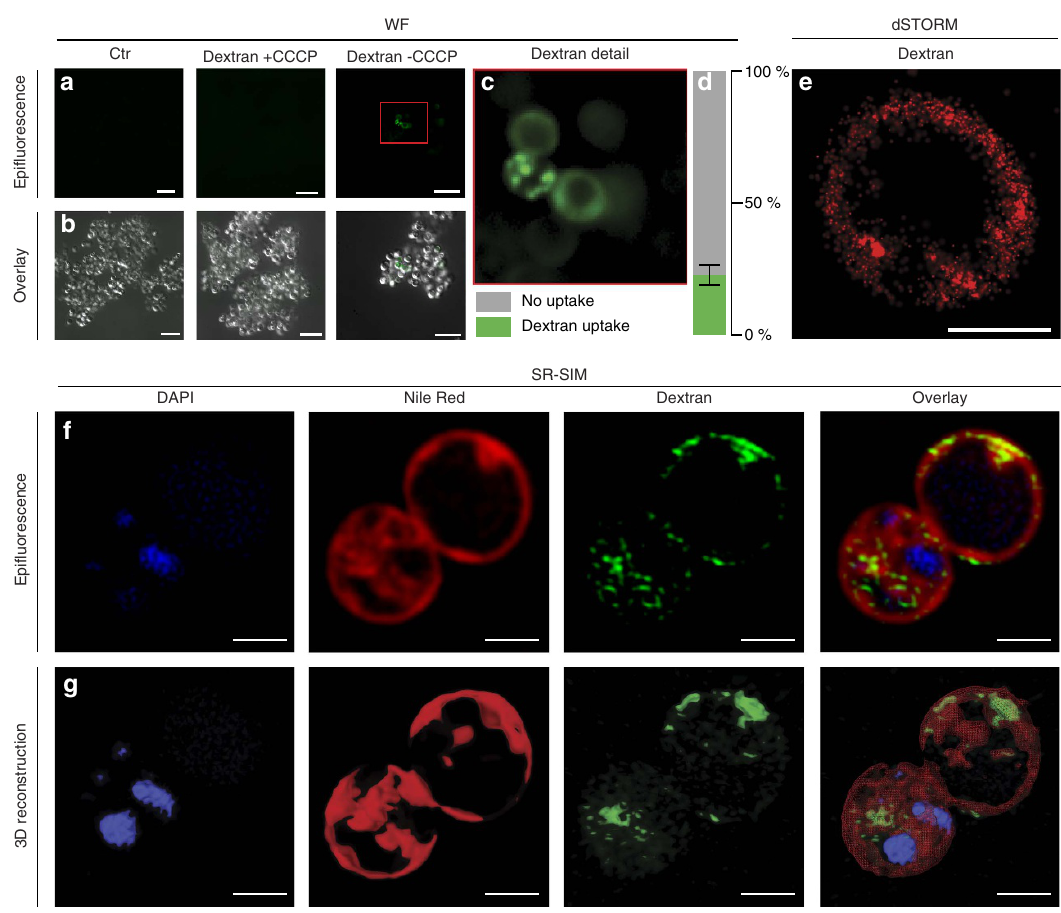
Figure 5 | Gemmata obscuriglobus takes up high-molecular weight dextran polysaccharides. ( a – c ) Wide field (WF) microscopy of G. obscuriglobus cells that were either untreated (Ctr) or fed with fluorescein-labelled 40kDa dextran (Dextran). Prior to addition of dextran cell samples were either poisoned with carbonyl cyanide m-chlorophenyl hydrazon ( þ CCCP) or left untreated ( (cid:2) CCCP). Epifluorescence overview micrographs ( a ) were combined with differential interference contrast images of the same field of view ( b ). Dextran fluorescence signals (green) were exclusively detected in (cid:2) CCCP cells, indicating an active uptake. Scale bars, 10 m m. ( c ) Magnification of the red framed section in a shows distinct foci of dextran accumulation. Scale bar, 10 m m. ( d ) While representative images are shown in ( a – c ), in total 1,065 cells among 7 fields of view were analysed and 23% of them showed dextran uptake (error bars indicate s.d.). In contrast, among 816 CCCP treated cells not a single uptake event was observed. ( e ) Super-resolution direct stochastic optical reconstruction microscopic (dSTORM) analysis of G. obscuriglobus cells fed with Alexa 467-labelled 10kDa dextran. The red fluorescence signals show an almost homogeneous distribution of dextran in some areas of the cell (see Supplementary Fig. 8a–f for details). Scale bar, 1 m m. ( f ) Super-resolution structured illumination microscopy (SR-SIM) of G. obscuriglobus cells with DAPI stained nucleoids (blue) and Nile Red stained membranes fed with fluorescein-labelled 40kDa dextran (green). The nucleoid is highly condensed and multiple invaginations of the innermost membrane are visible that colocalise with the invaginated innermost membrane (Overlay). 3D reconstruction with Amira 6.0 shows dextran within the G. obscuriglobus cell ( g and Supplementary Movie 3). Scale bars, 1 m